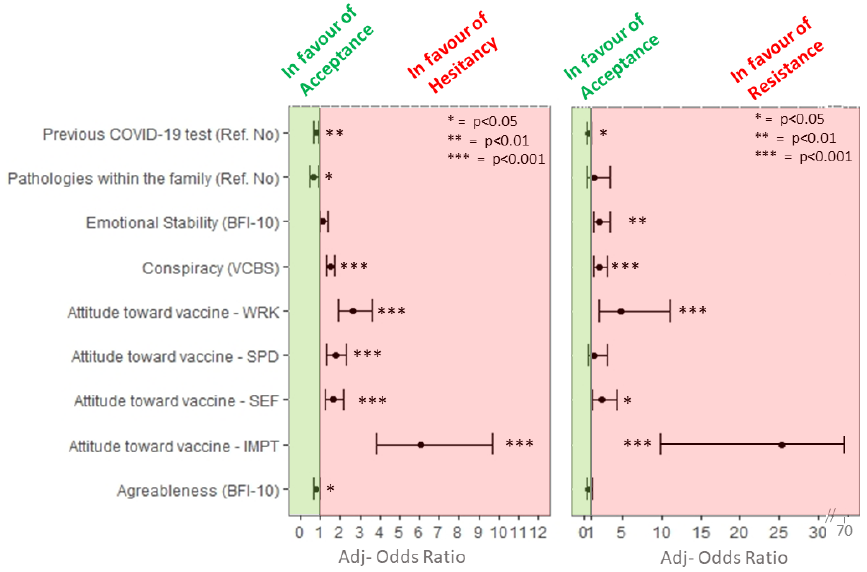
Figure 2. Multivariable analysis including variables statistically significantly associated with mRNA vaccine hesitancy. * p < 0.05; ** p < 0.01; *** p <